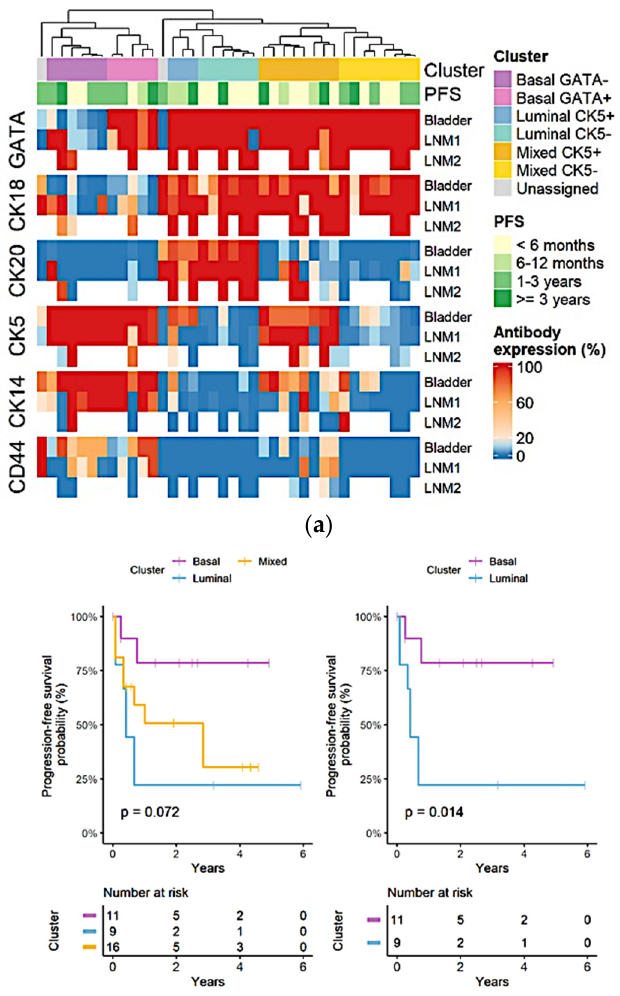
Figure 6. Heatmap of antibody expression (%) for bladder and pelvic lymph node metastasis tissues ( a ). Survival analysis of IHC clusters suggested a significant association between cluster identity and progression-free survival (PFS) rate. Specifically, luminal and basal IHC clusters were significantly associated with PFS rates ( b ).